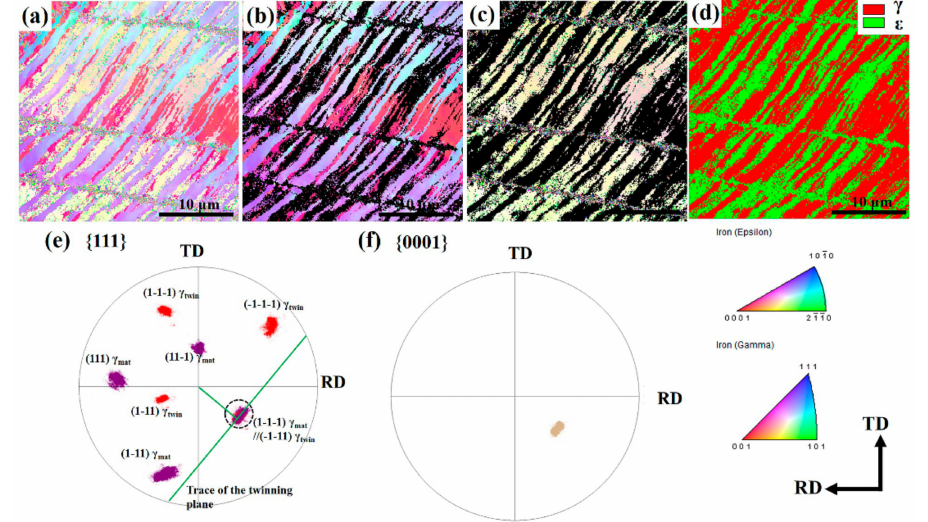
Figure 8. Microstructure of tensile deformed specimen after 35% warm rolling reduction, taking at the framed area in Grain 1: ( a ) The RD orientation maps for all data, ( b ) the FCC structures, ( c ) HCP structures, ( d ) phase map, ( e ) {111} pole figure and ( f ) {0001} pole